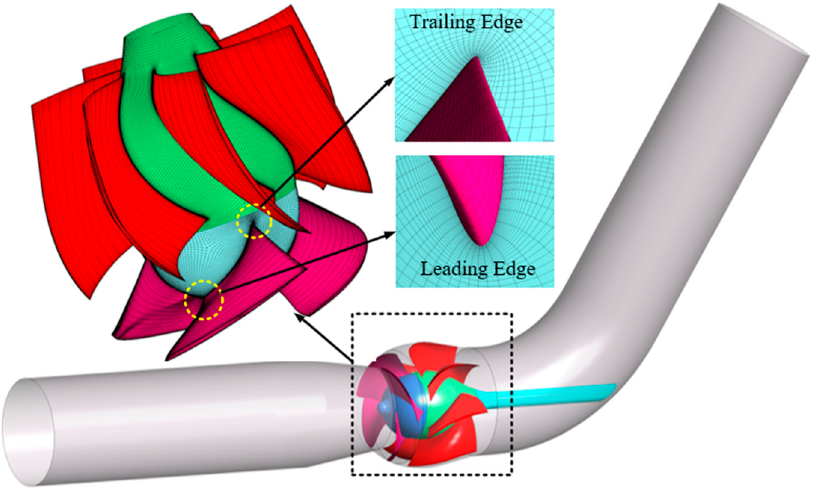
Figure 4. Mesh of computational domains.